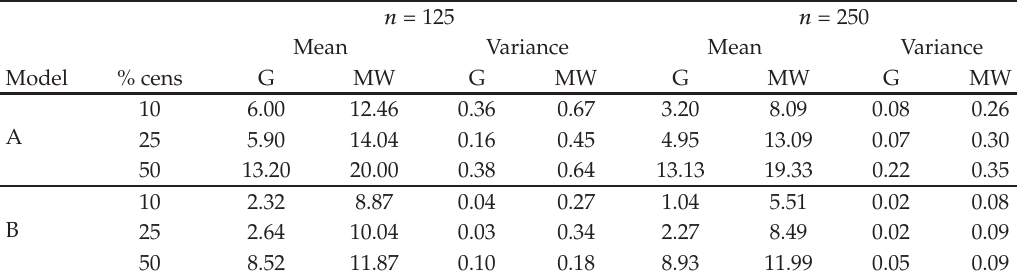
Table 3: Mean and Standard deviation (cid:3) × 10 − 2 (cid:4) of L 2 error for the hazard rate function